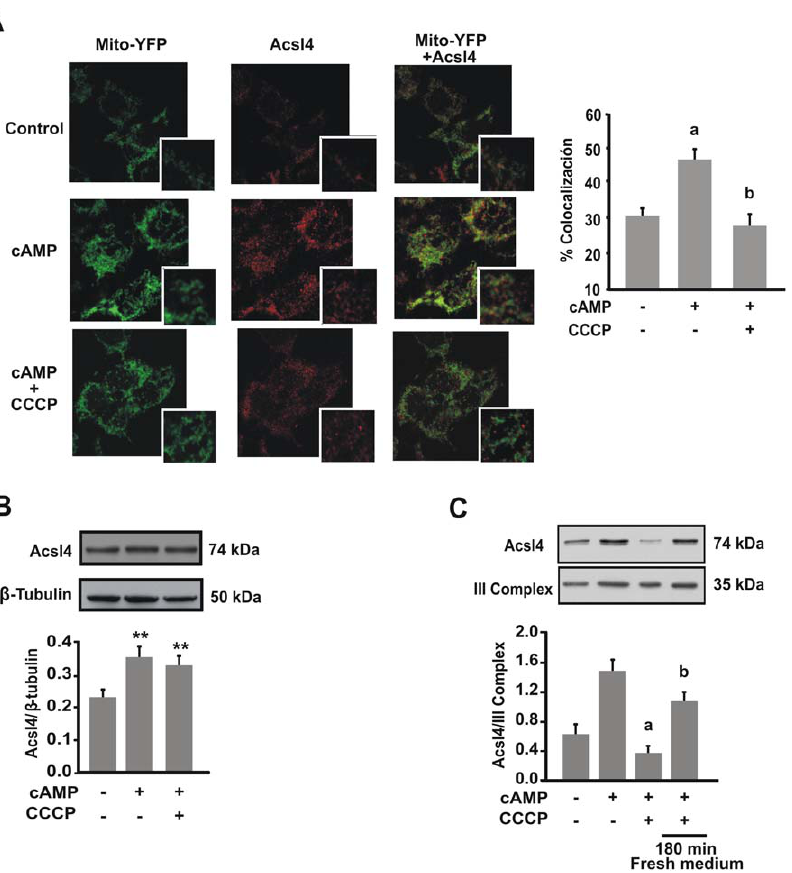
Figure 4. Hormonal stimulation allows an association between mitochondria and the MAM. A. After 24 hour transfection with mt-YFP (green), MA-10 cells were treated with or without CCCP (5 m M) and 8Br-cAMP (1 mM) for 1 h. Representative immunofluorescence to confocal section of co-localization between mitochondria and the MAM (Left panel). The MAM was stained with Acsl4 polyclonal antibody (red) followed by secondary antibody conjugated with Cy3 fluorofore as described in materials and methods. Signal overlap was quantified using MBF-Image J (Right panel). Pearsons colocalization coefficients were calculated from three independent experiments and then converted to percentages. Data represent means 6 SEM. a P , 0.001 vs. control and b P , 0.001 vs. 8Br-cAMP. B. MA-10 cells were treated with or without CCCP (5 m M) and 8Br-cAMP (1 mM) for 1 h. Total proteins were obtained and western blotting was performed. An image of a representative western blot is shown. Membranes were sequentially blotted with anti-Acsl4 and anti- b -tubulin antibodies. For each band, the optical density (OD) of the expression levels of Acsl4 protein was quantified and normalized to the corresponding b -tubulin protein. The relative levels of Acsl4 protein are shown. Data are presented as an average SEM of three independent experiments. ** P , 0.01 vs. control. C. MA-10 Cells were treated with or without CCCP (5 m M) and 8Br-cAMP (1 mM) for 1 h, or incubation with CCCP and 8Br-cAMP for 1 h followed by washout and 3 h recovery. Mitochondria were isolated and western blotting was performed. An image of a representative western blot is shown. Membranes were sequentially blotted with anti-Acsl4 and anti-OxPhos complex III core 2 subunit (III Complex) antibodies. For each band, the OD of the expression levels of Acsl4 protein was quantified and normalized to the corresponding III Complex protein. The relative levels of Acsl4 protein are shown. Data are presented as an average SEM of three independent experiments. a P , 0.001 vs. 8Br-cAMP and b P , 0.001 vs. control.